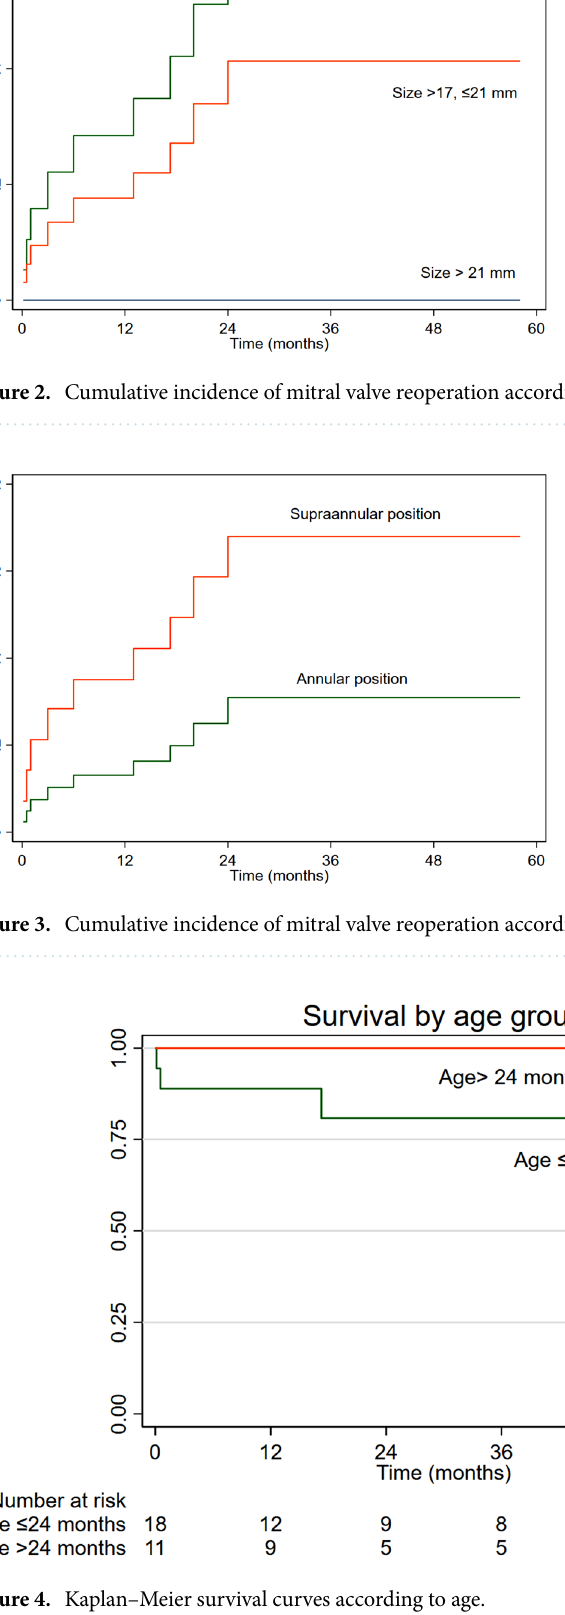
Figure 4. Kaplan–Meier survival curves according to